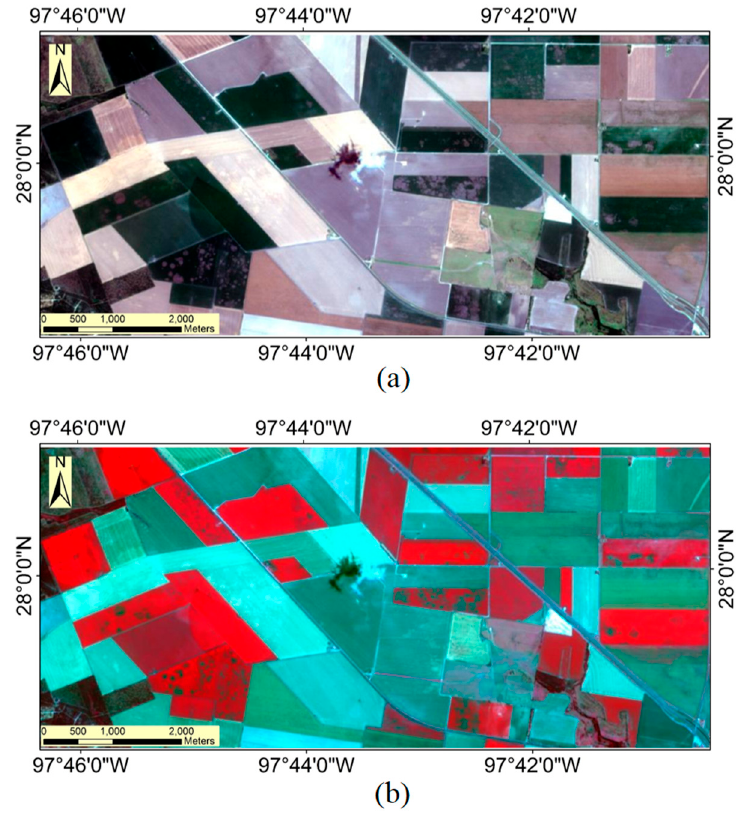
Figure 3. Sentinel-2A multispectral instrument (MSI) image for the study area. ( a ) True color image; ( b ) color infrared (CIR) composite image.